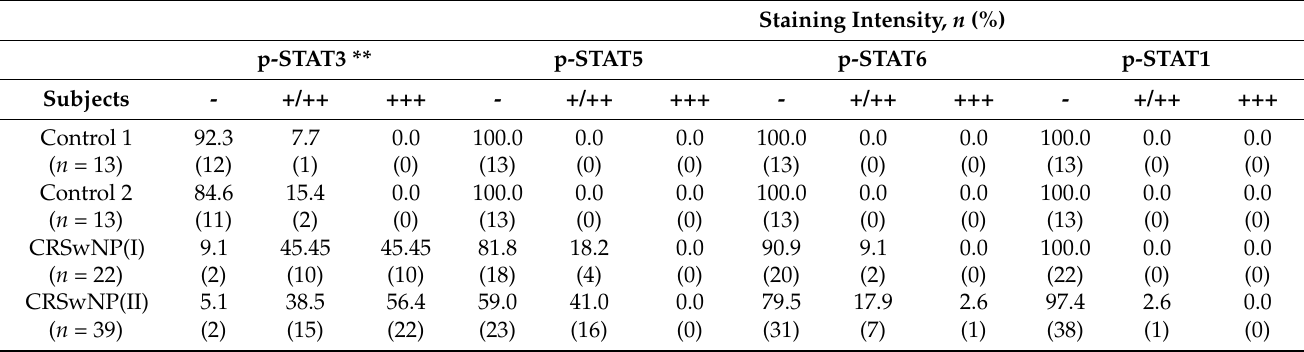
Figure 2. The expression of p-STAT3, p-STAT5, and p-STAT6 for the nasal polyp tissues in control 1, control 2, CRSwNP(I), and CRSwNP(II) groups evaluated by immunohistochemistry. Black arrows: epithelial cell staining; and red arrows: inflammatory cells staining. Scale bar = 50 μ m. Table 5. Distribution by immunohistochemistry of intensity for p-STAT1, p-STAT3, p-STAT5, and p-STAT6 in control groups and CRSwNP groups.